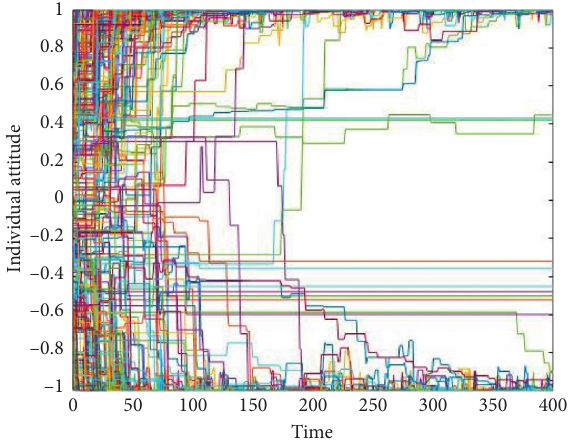
Figure 7: Individual attitude with number of